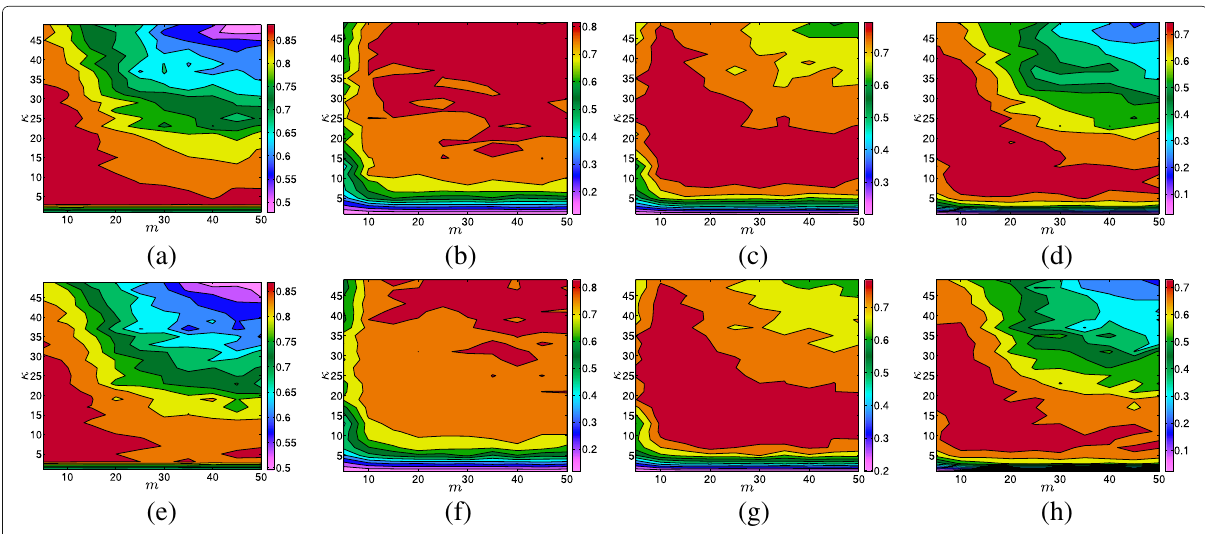
Fig. 2 How κ and m affect the clustering quality. a Precision rates on D 4 , b recall rates on D 4 , c F1-measures on D 4 , d adjusted Rand Indexes on D D D D 4 , e precision rates on 5 , f recall rates on 5 , g F1-measures on 5 , and h adjusted Rand Indexes on